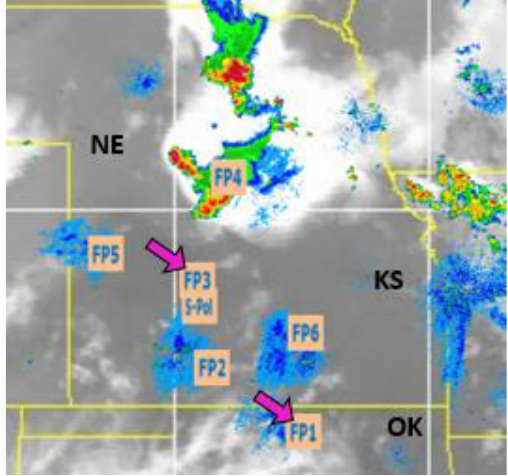
Figure 2. Radar mosaic at 0615 UTC. Ground sites, including FP1 and FP3, are identified. Shading is GOES-13